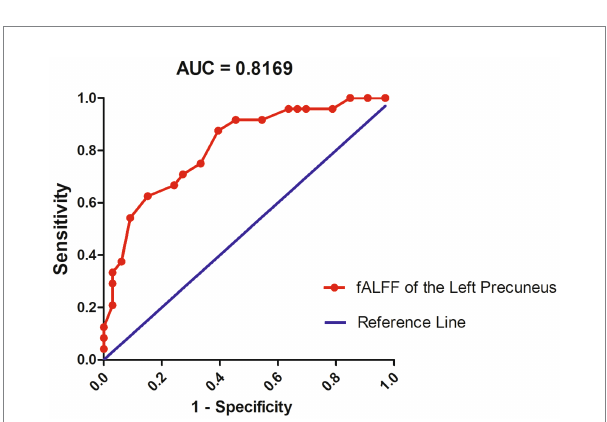
FIGURE 3 Receiver operating characteristic (ROC) results indicated that fALFF values in the left precuneus could discriminate Pa_s from Pa_ns . Pa_s , major depressive disorder with sleep disturbance; Pa_ns, major depressive disorder without sleep